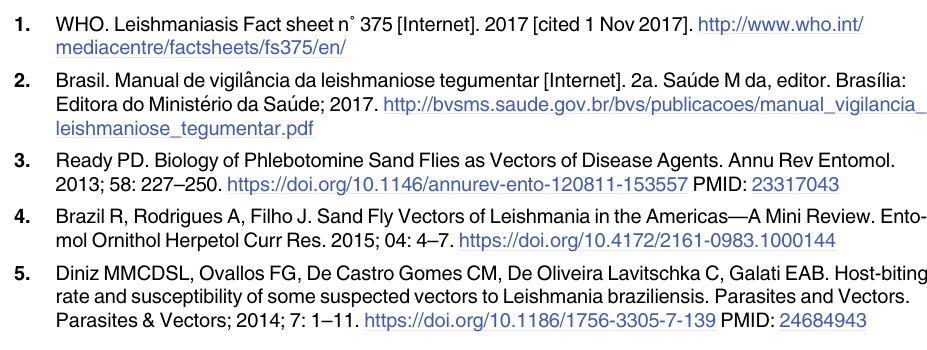
S1 Table. Raw data of attractiveness tests in Y-tube olfactometer for uninfected and infected mice. S2 Table. Volatile compounds tentatively identified based on retention time (in ascending order) and their respective experimental and literature retention